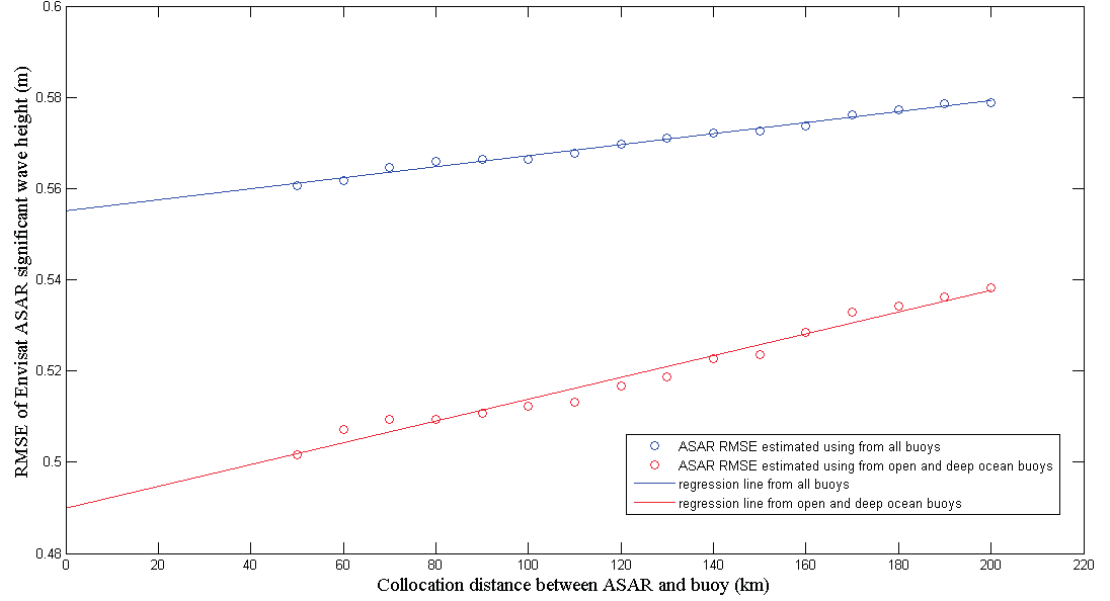
Figure 7. Change of Envisat ASAR wave mode SWH errors as functions of the collocation distance. Circles and lines refer the RMSEs of ASAR SWH estimated from triple collocations and the regression lines, respectively. Blue and red symbols indicate the results from all buoys and deep-and-open-ocean buoys,